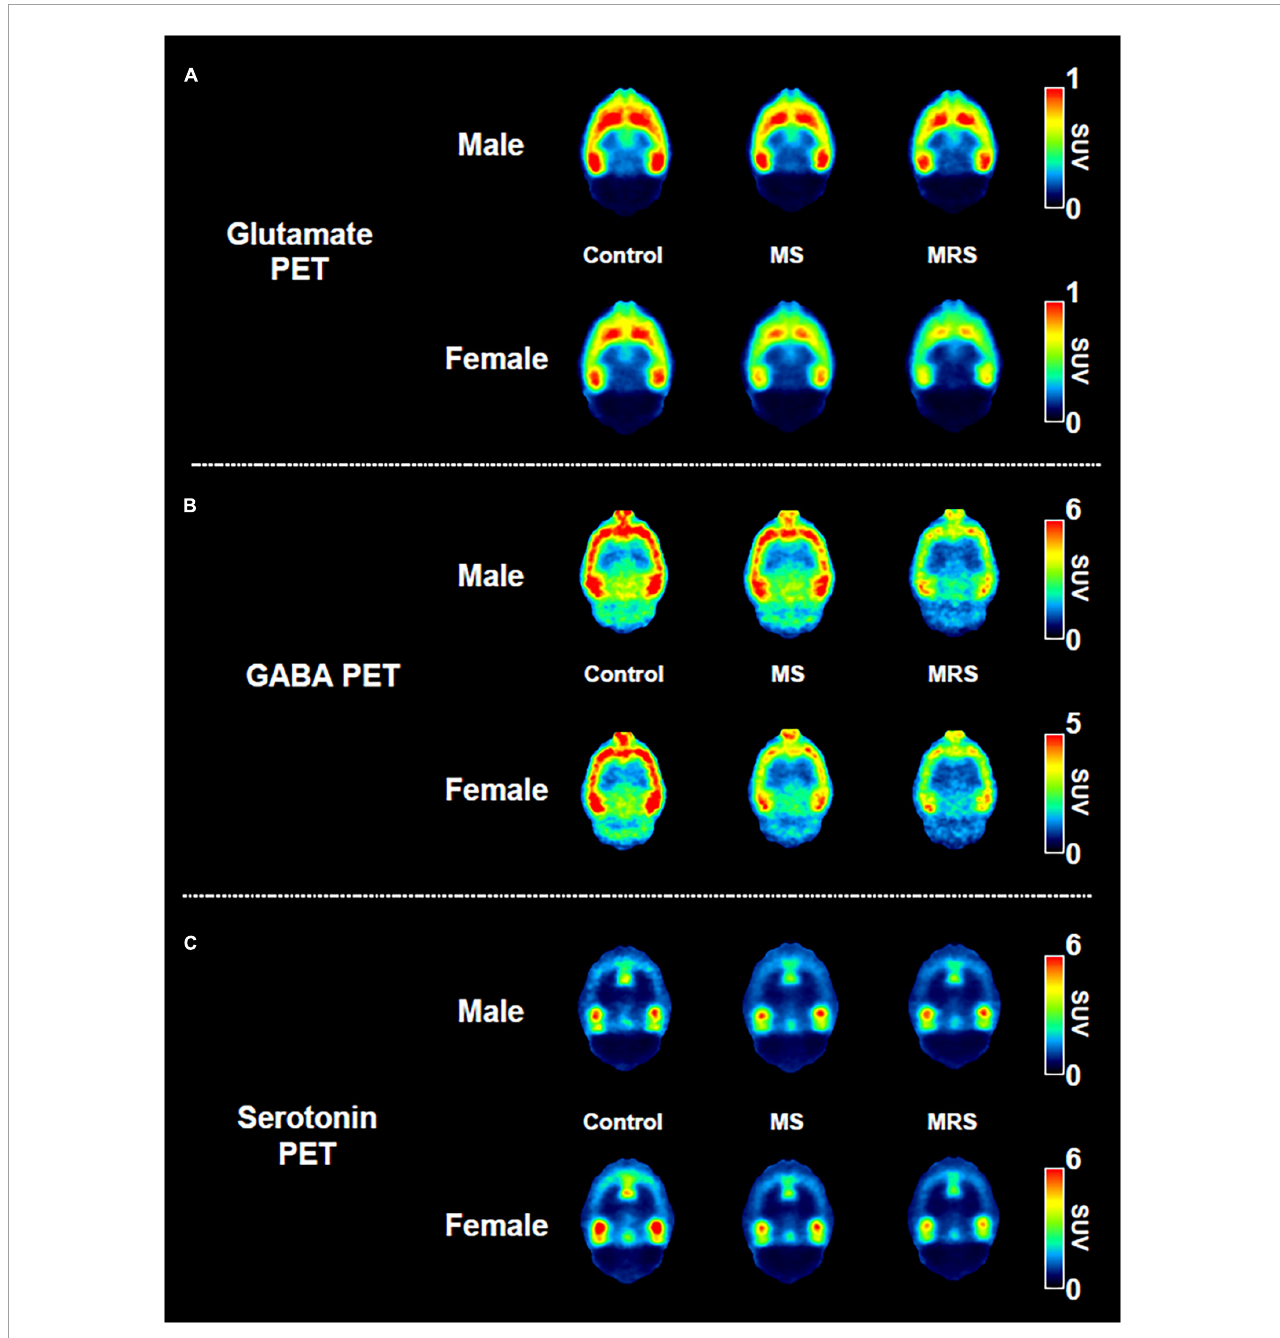
FIGURE5 Comparison of the neuroreceptor PET images of glutamate (A) , GABA (B) , and serotonin. (C) The mean PET images were obtained from 40 to 60 min and categorized as male and female.